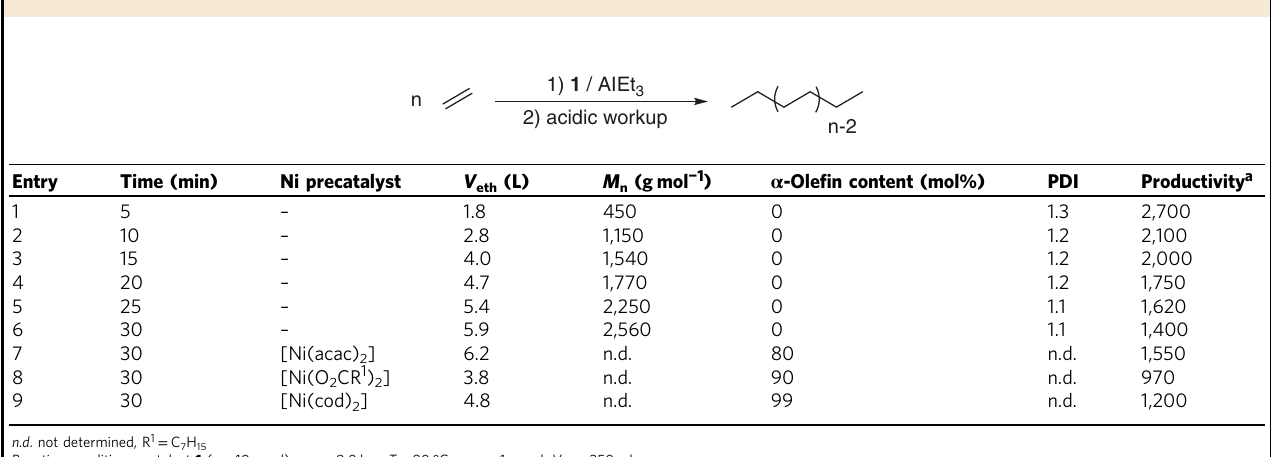
Table 1 Time-dependent CCTP of ethylene using catalyst 1 and 1 mmol of